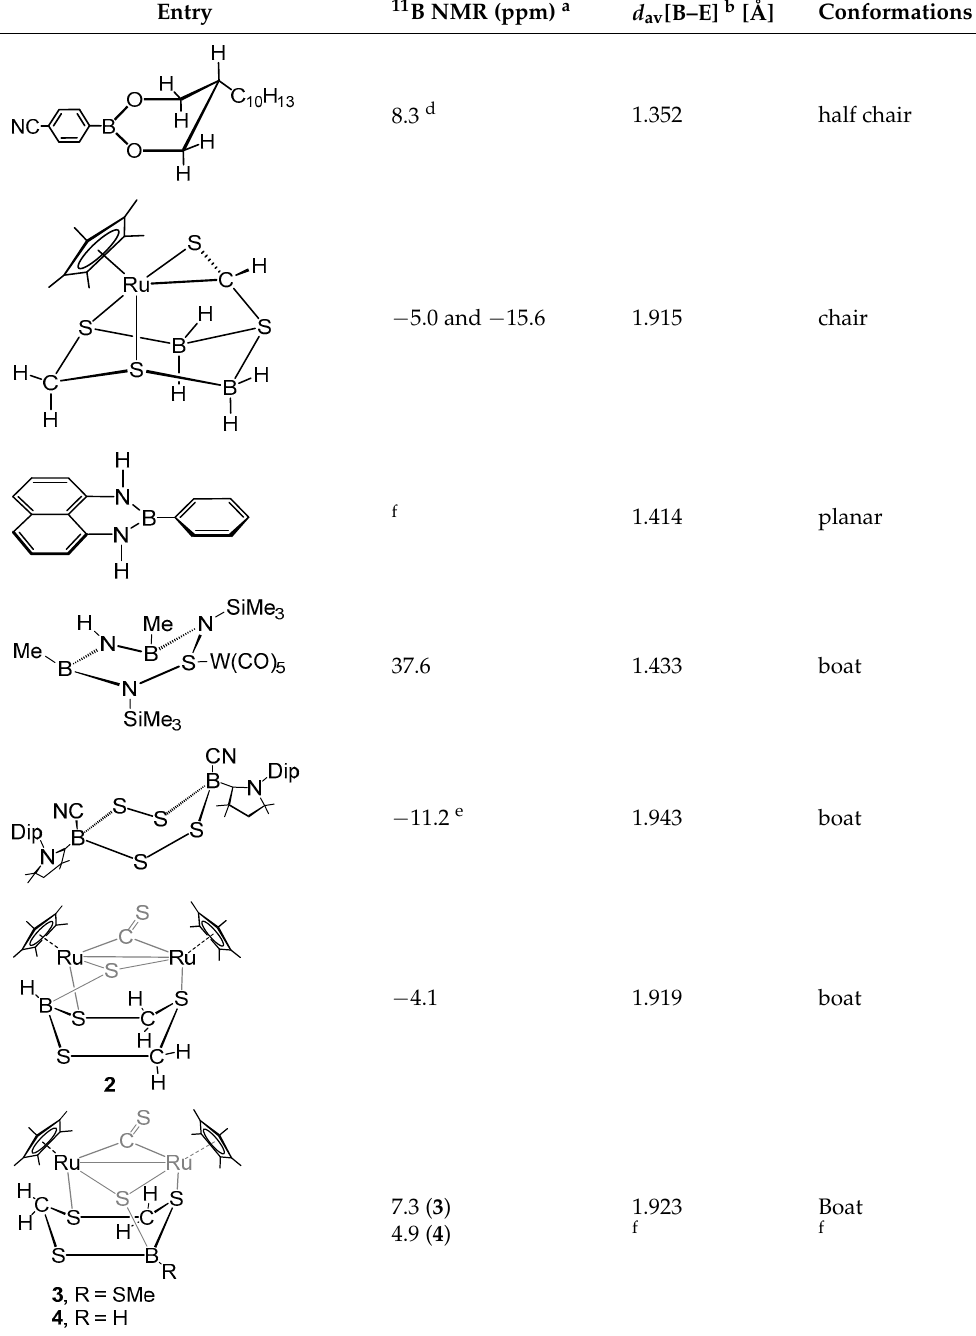
Table 1. Selected structural and spectroscopic data of borinane derivatives and complexes [33,75–78].